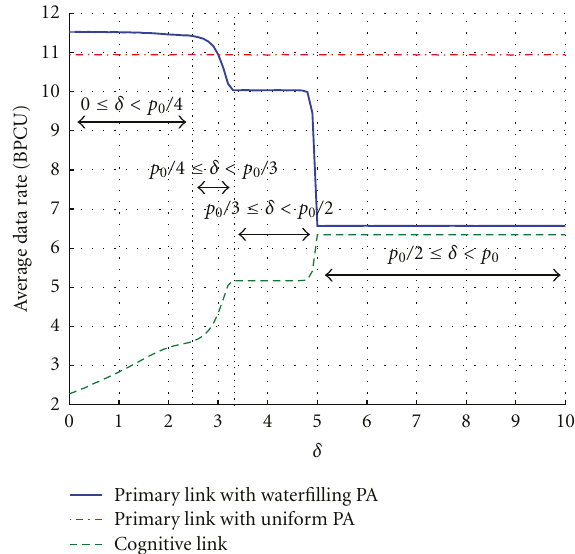
Figure 2: Average data rate for both the primary and the secondary networks versus SNR for di ff erent numbers of antennas; M = 2,4,6,8 and, δ = 0 (conventional WPA).